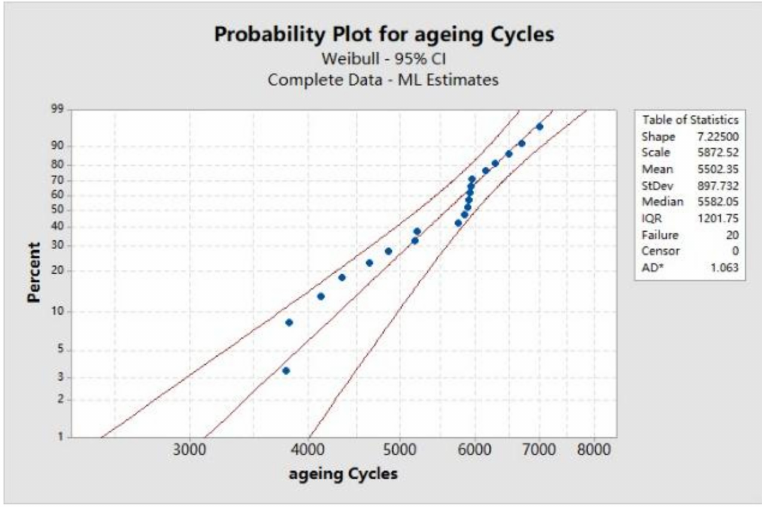
Figure 12. ( a ) Von Mises plastic strain distribution of solder joints with randomly distributed voids under the thermal shock test; ( b ) Von Mises plastic strain of solder joints with randomly distributed voids vs. time.